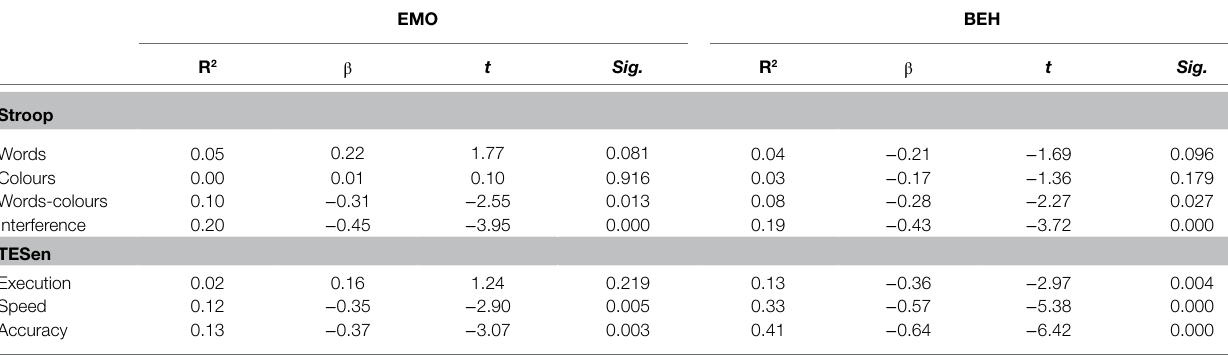
TABLE 4 | Regression analysis concerning the executive processes and emotional problems and behavioural problems. EMO BEH R 2 β t Sig. R 2 β t